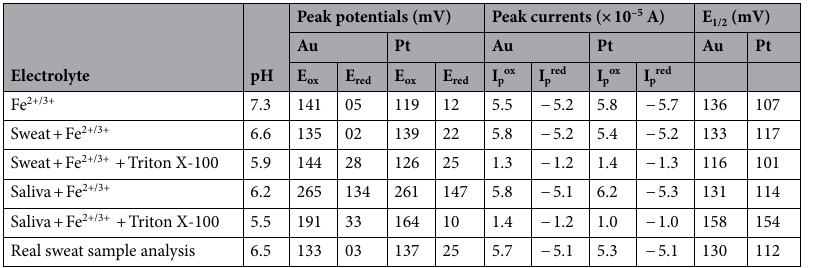
Table 1. pH, peak potential values (Oxidation—E ox ; Reduction—E red ), peak current values (Oxidation—I pox ; Reduction—I pred ) and half-wave potential values (E 1/2 ) at a scan rate of 50 mV/s for Au and Pt electrodes obtained from the CV curves recorded using [Fe(CN) 6 ] 3−/4− redox couple for various sweat and saliva bio- mimic solutions studied in this